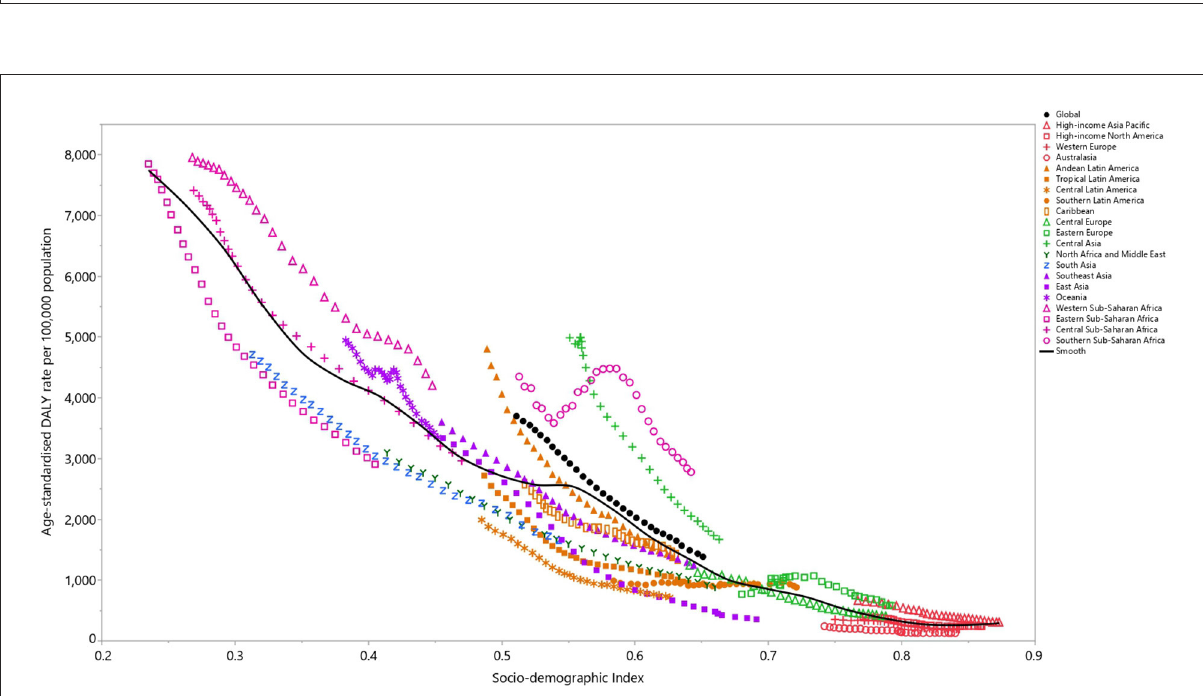
FIGURE4 Age-standardized DALY rates of lower respiratory infections for the 21 Global Burden of Disease regions by Socio-demographic Index, 1990–2019; Expected values based on Socio-demographic Index and disease rates in all locations are shown as the black line. Thirty points are plotted for each GBD region and show the observed age-standardized DALY rates from 1990 to 2019 for that region. DALY, disability adjusted life years (generated from data available from